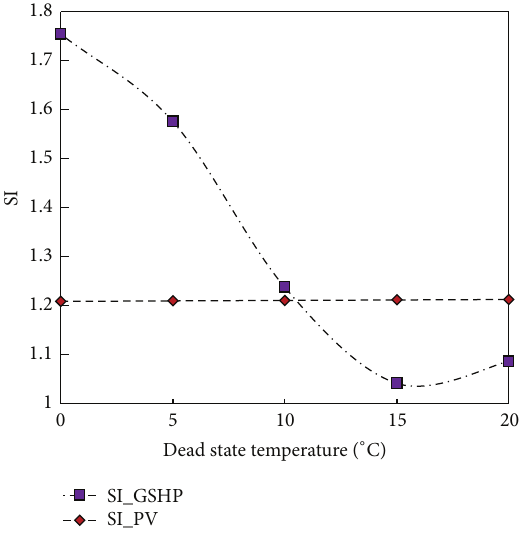
Figure 7: Sustainability index of the GSHP and PV systems versus dead state